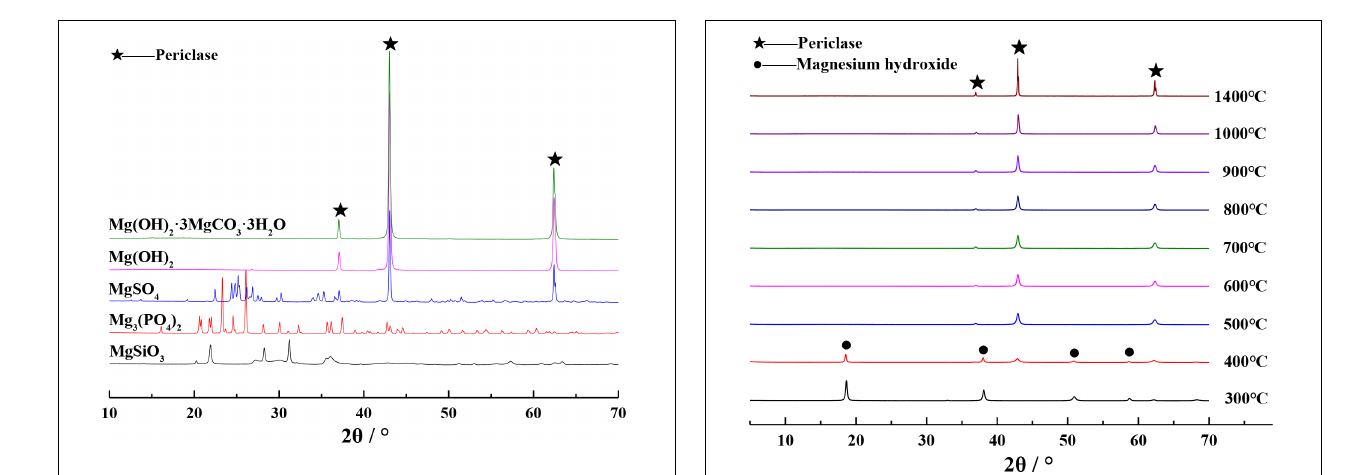
FIGURE 4 | XRD patterns of calcined products of Mg(OH) 2 at different